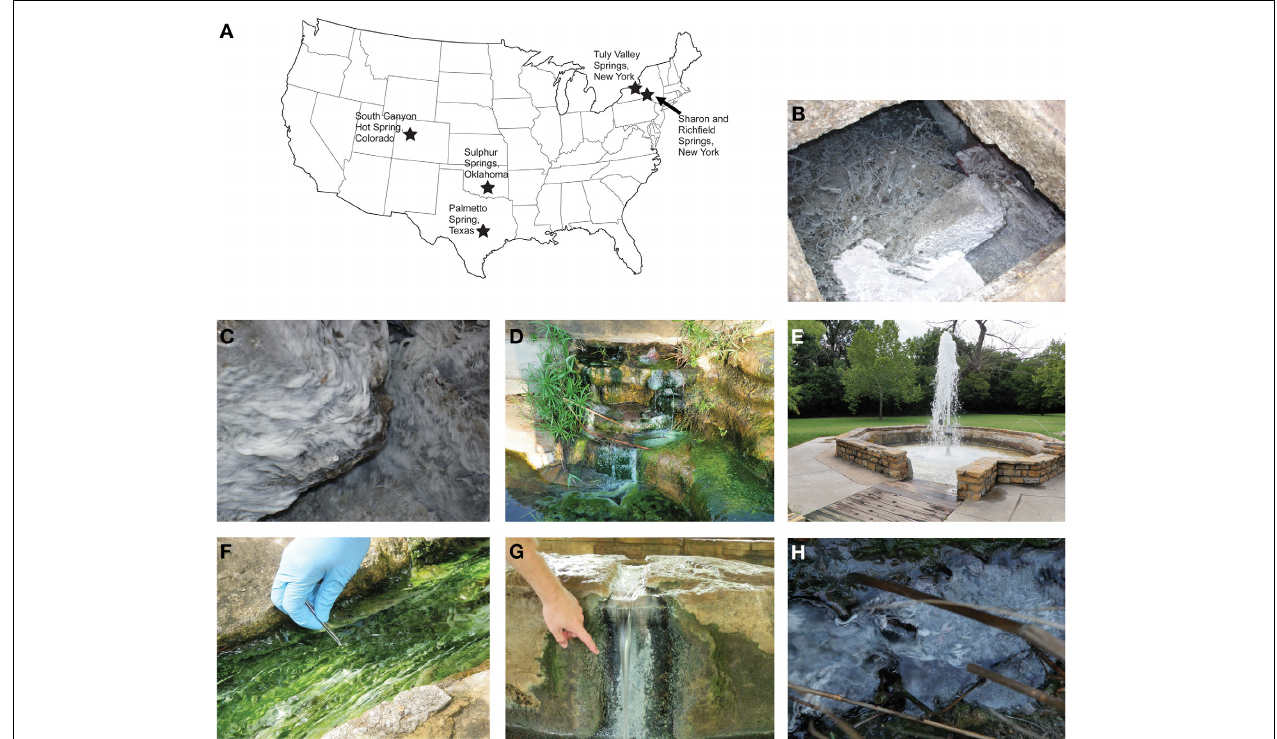
FIGURE 1 | (A) General locations of terrestrial sulfidic springs where microbial mats were sampled in this study. Map graphic modified from http:// www . pageresource . com/clipart. Representative photographs from each sampling location: (B) looking into the cistern at Sharon Springs (photograph is ∼ 1m across); (C) close-up of microbial mats colonizing concrete basin at